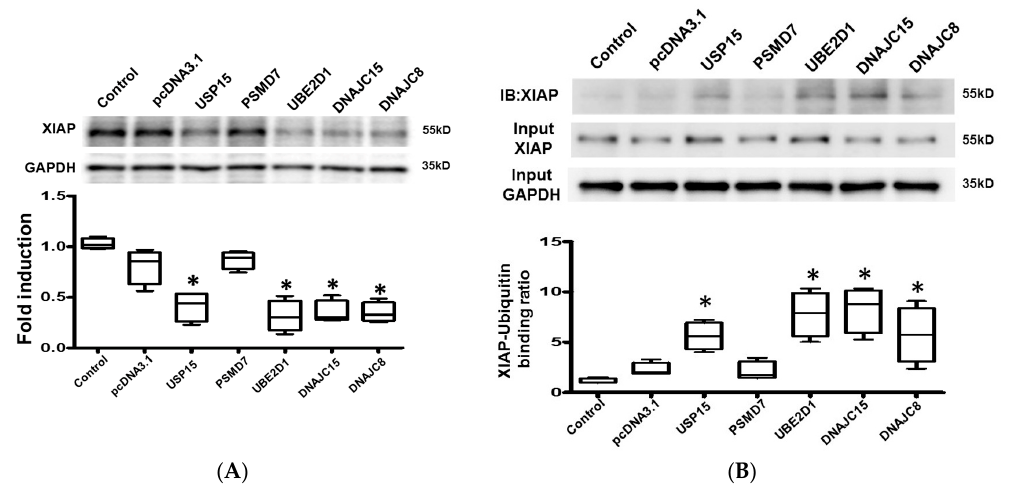
Figure 5. Effects of ubiquitination-related genes on X-linked inhibitor of apoptosis protein (XIAP). ( A ) Representative blots and box-and-whisker Western blot analysis of XIAP. ( B ) Representative blots and box-and-whisker Western blot analysis of XIAP immunoprecipitated with ubiquitin. The relative expression levels of proteins corresponding to GAPDH were quantified by densitometry. * p < 0.05 versus control. n = 3 to 5 samples for each experiment.